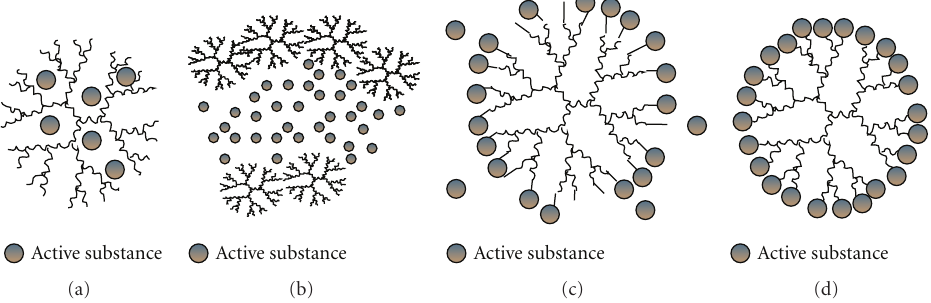
Figure 3: Principal ways to use dendrimers as drug carrier ( Source : Schmid et al ., Nanotechnology assesments and prospective , 2006 , Sprin- ger ).